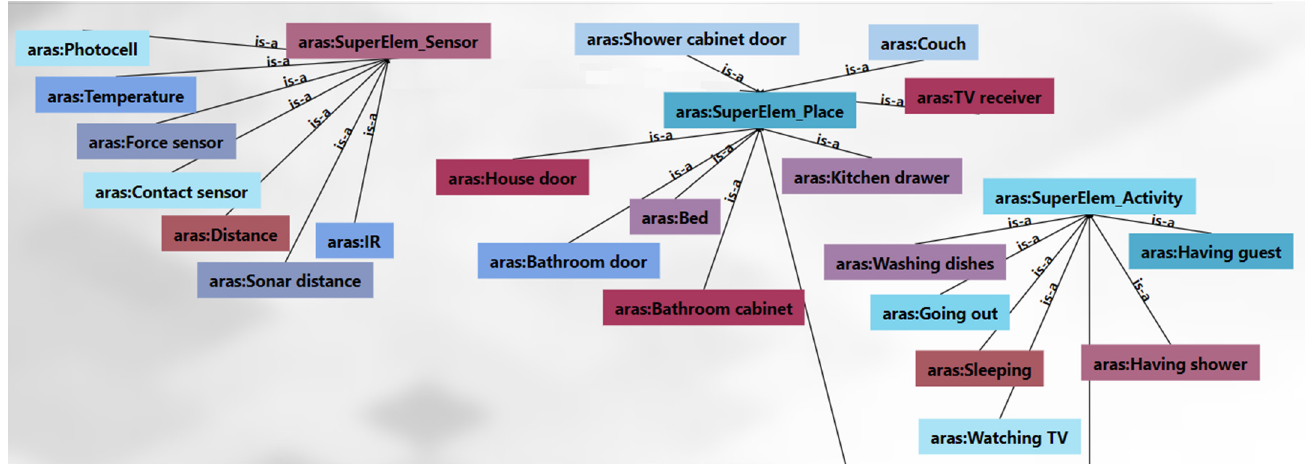
Figure 17. Ontology-based model learning at 𝑡 (cid:2870) in the learning phase, an excerpt of the local ontology.